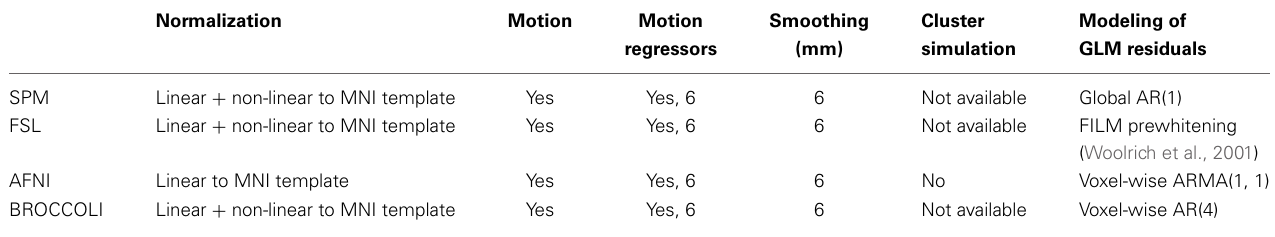
Table 2 | Settings for first level analysis for the different software packages (for AFNI it is currently not possible to select non-linear registration in the graphical user